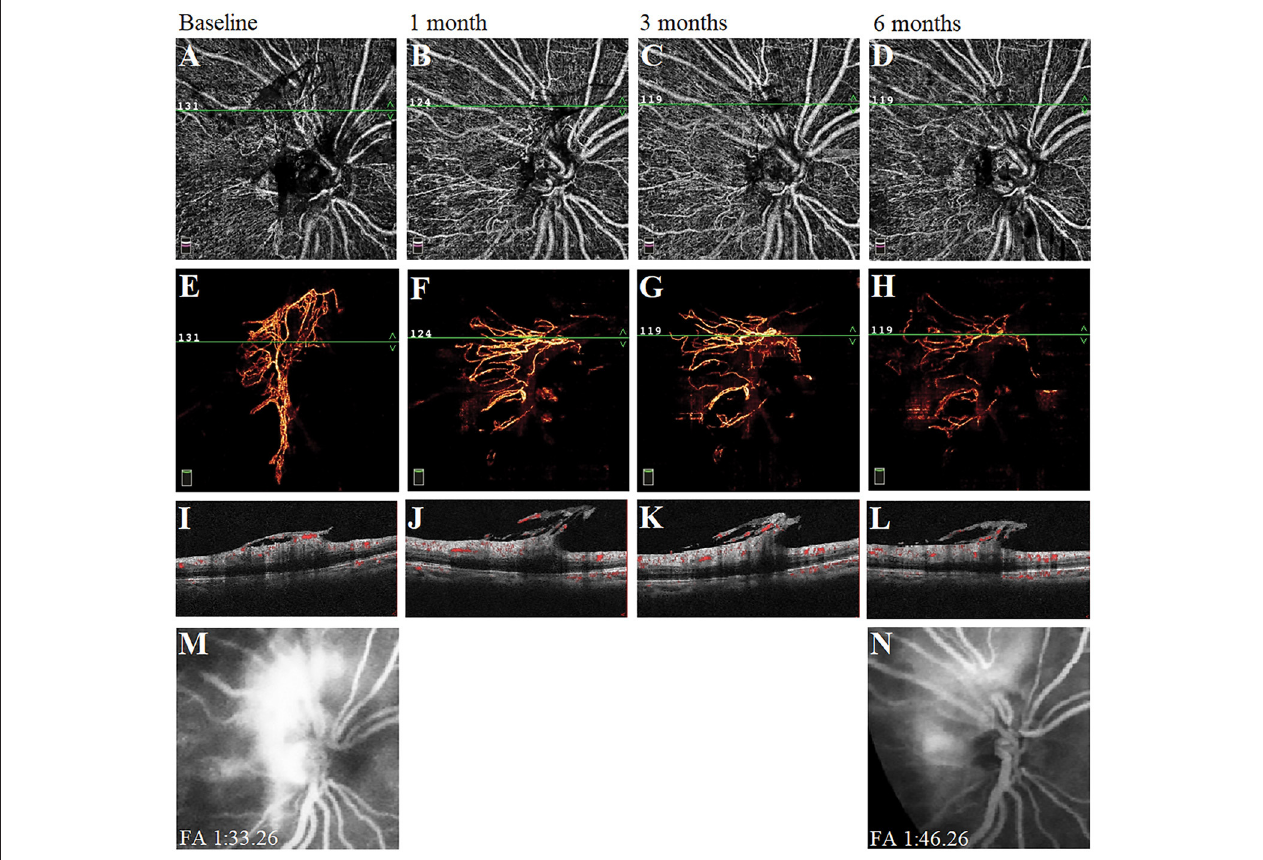
FIGURE 3 | A typical proliferative diabetic retinopathy case showed the neovascularization of the disk (NVD) changed from large, dense, and strong fluorescein leakage to small, loose, and weak fluorescein leakage at 6 months after panretinal photocoagulation (PRP). (A–D) Retina en-face slab images of NVD were observed by optical coherence tomography angiography (OCTA). (E–H) Vitreous en-face slab images of OCTA. (I–L) B-scan image of OCTA. (M,N) Images of fluorescein angiography at baseline and 6